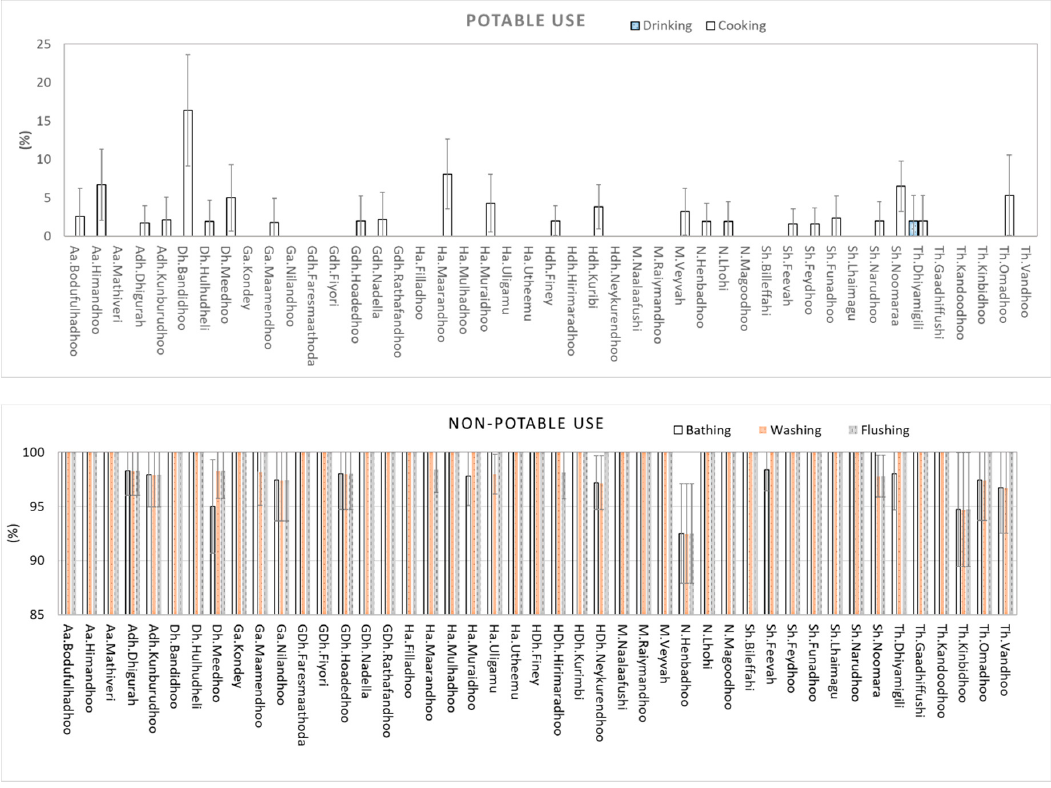
Figure 4. Fraction of respondents using groundwater for different purposes. Top : Potable use. Bottom : Non-potable use. (Note: The Y-axis scale is from 85% to 100%.) The margin of error for a 95% confidence level is indicated as error bars.